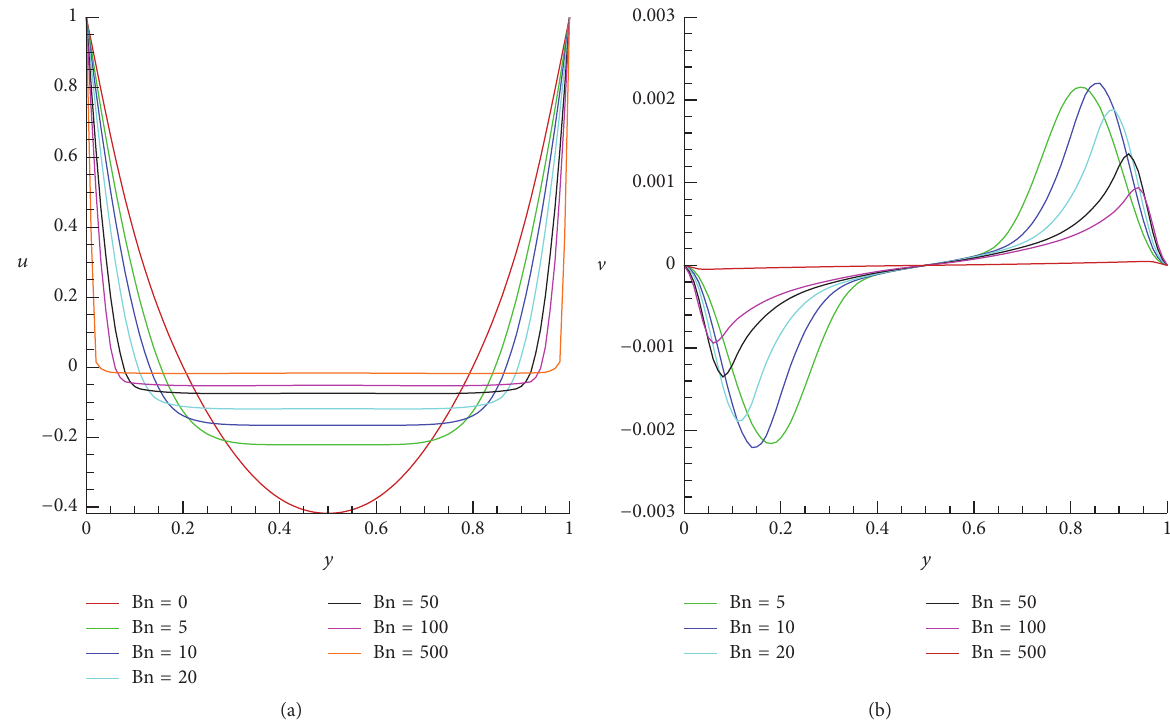
Figure 8: Vertical cut-lines at 𝑥 = 0.5 for 𝑢 velocity and V velocity for different values of Bingham